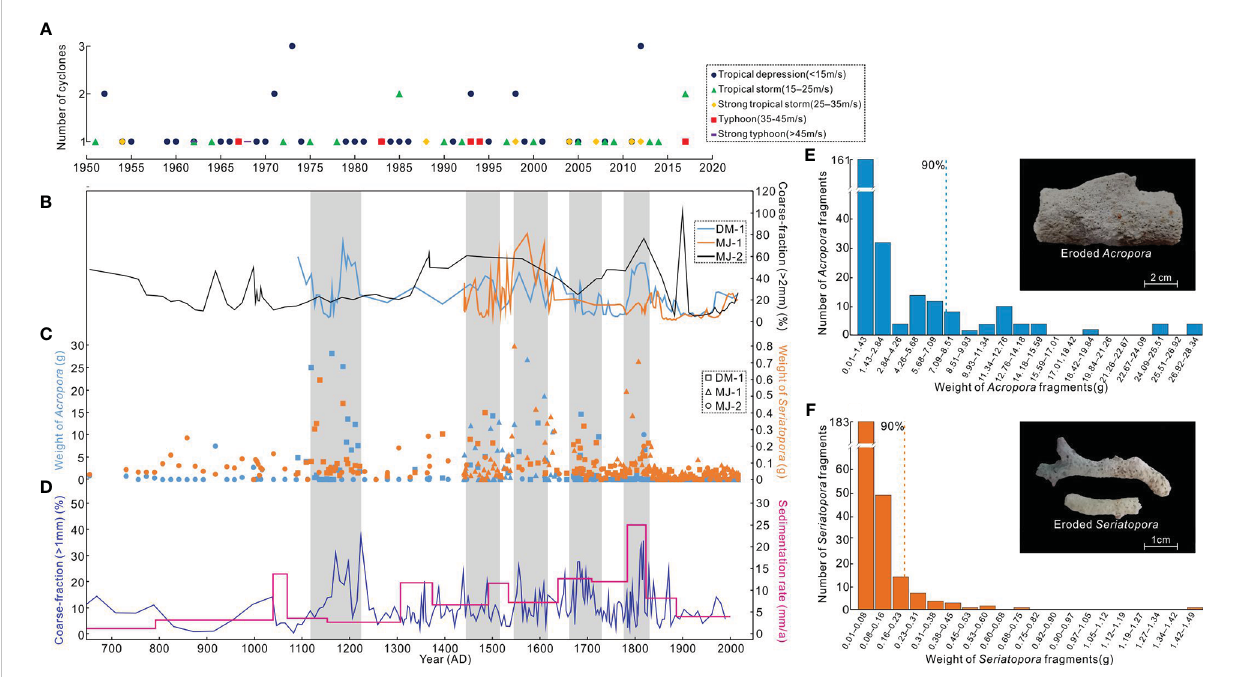
FIGURE 7 Excluding cyclone-deposited subfossils from the core sediments: (A) Historical tropical cyclones that had the potential to impact our study sites (9 − 11°N, 114 − 116°E); (B) Coarse-fraction (> 2 mm) percentages of cores DM-1, MJ-1, and MJ-2. The percentage was calculated as the weight of > 2-mm fraction divided by the weight of each sediment sample; (C) Weight of dominant branching ( Acropora and Seriatopora ) fragments from the reef cores; (D) Late- Holocene cyclone history of the Nansha (Yu et al., 2009) as revealed by coarse-fraction percentage and sedimentation rate extracted from the Yongshu lagoon (9.60°N, 112.95°E); (E, F) Weight frequency distributions of Acropora and Seriatopora fragments and representative photos of relatively large but heavily eroded coral